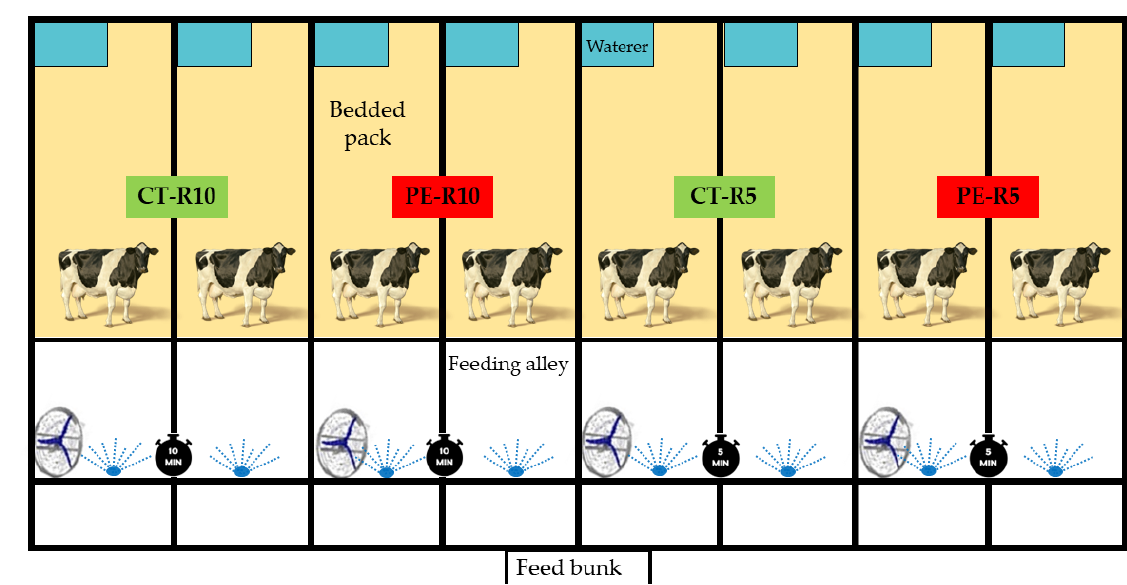
Figure 1. Schematic diagram of the trial: dairy cow barns with sprinkle and fan cooling systems. The cooling process consisted of spraying cycles and constant ventilation. The flow